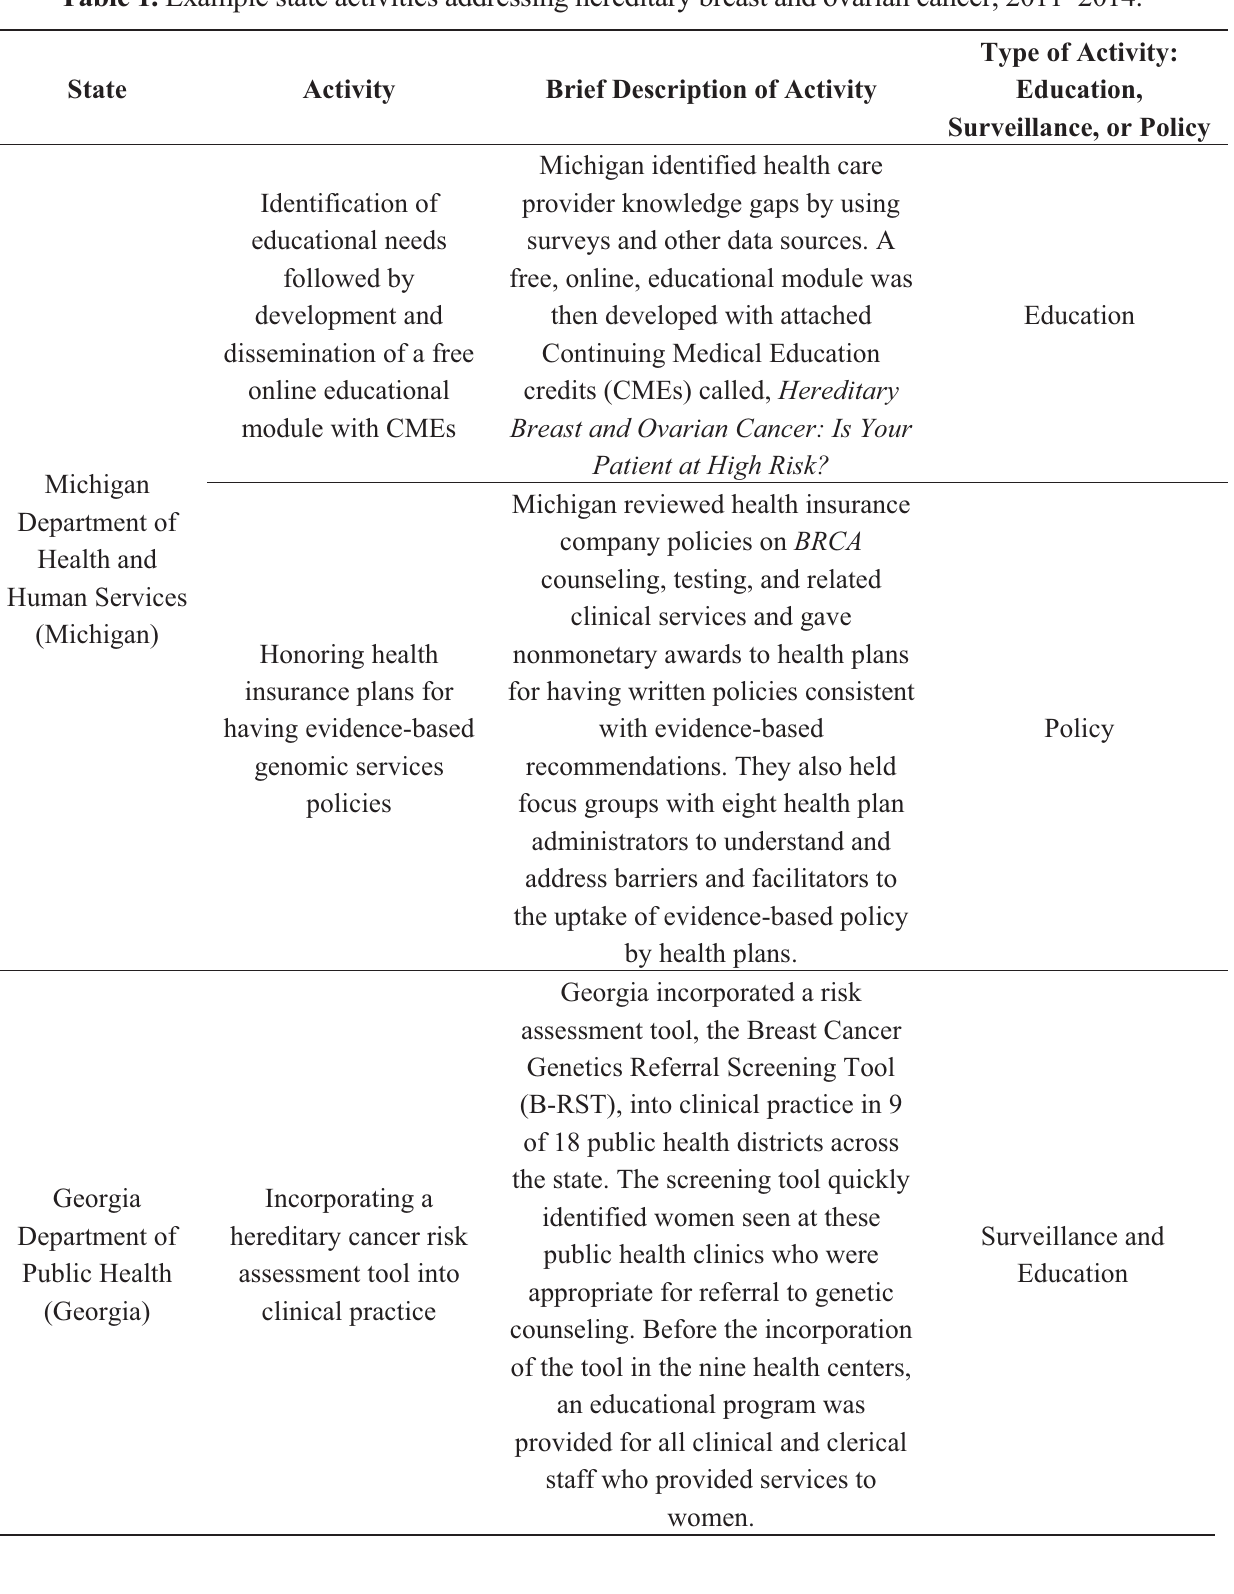
Table 1. Example state activities addressing hereditary breast and ovarian cancer, 2011 –